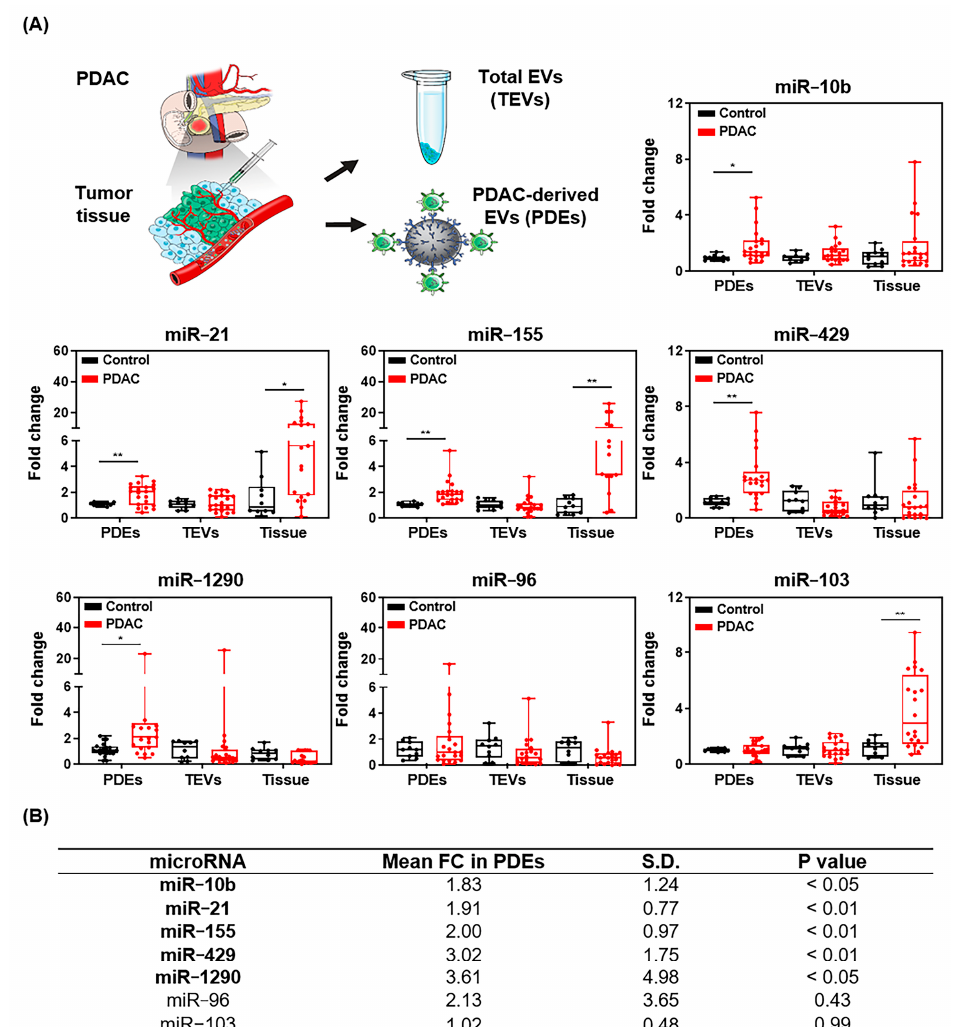
Figure 6. Differential miRNA expression in samples from 20 PDAC patients compared with the normal control. ( A ) Fold changes of candidate miRNA expression in PDEs, TEVs, and tumor tissue. ( B ) Mean fold changes, standard deviations, and P values of candidate miRNAs in PDEs. Upregulated miRNA candidates that were upregulated in PDEs are shown in bold. * p < 0.05, ** p < 0.01 benign control vs. PDAC in each groups.